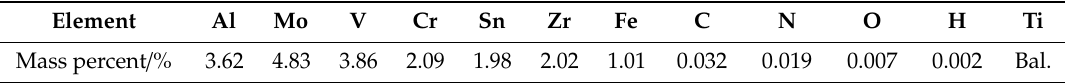
Table 1. The chemical composition of the Ti–3.5Al–5Mo–4V alloy.